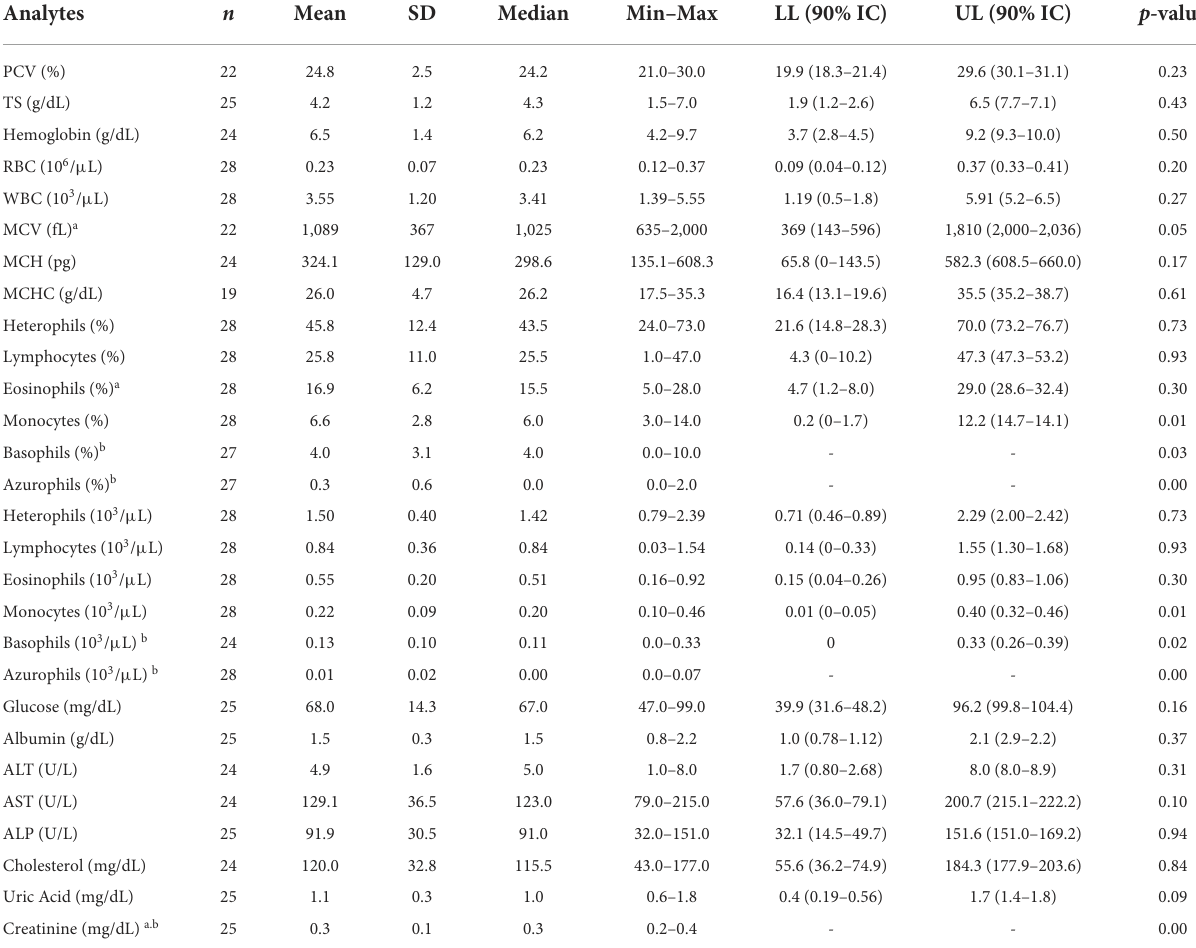
TABLE 2 Hematological and blood chemical values of the Savannah side-necked turtle ( P. vogli